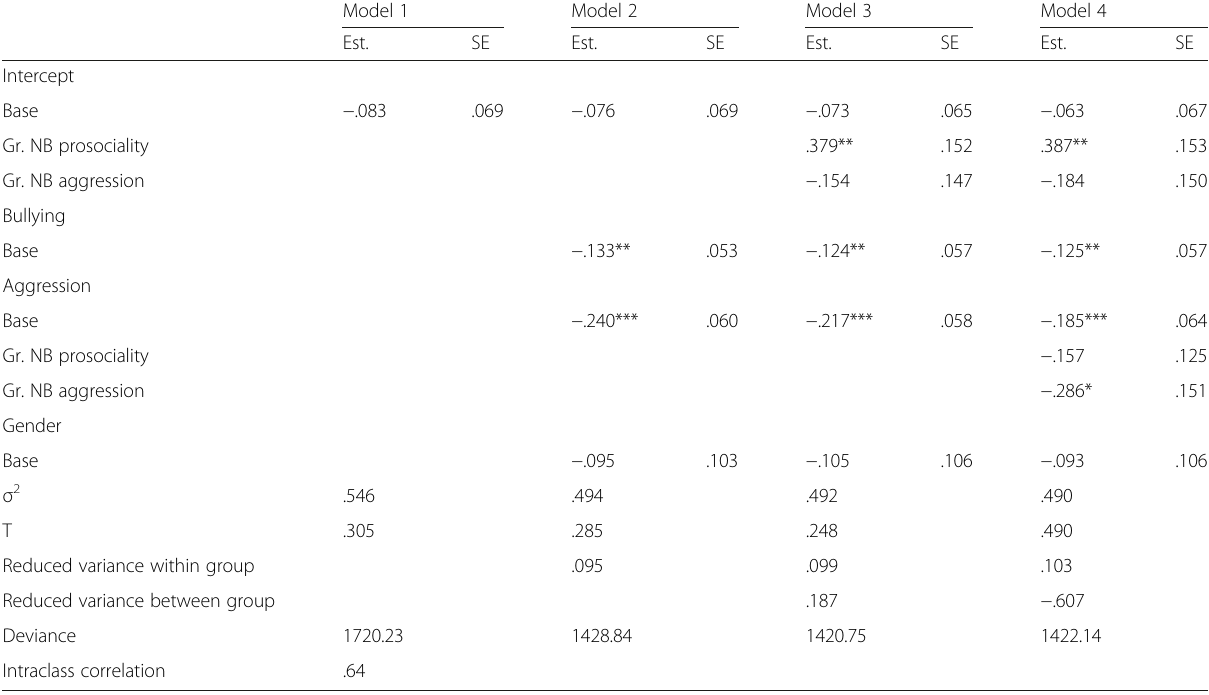
Table 3 HLM models regarding the effects of individual bullying, aggression, gender, and group normative beliefs about aggression and prosociality on individual social